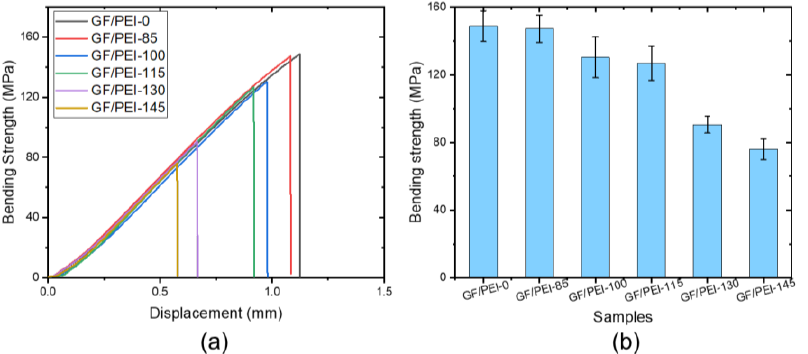
Figure 2. Bending stress-displacement curves of the samples ( a ), and bending strength of the aged samples as a function of temperature ( b ).